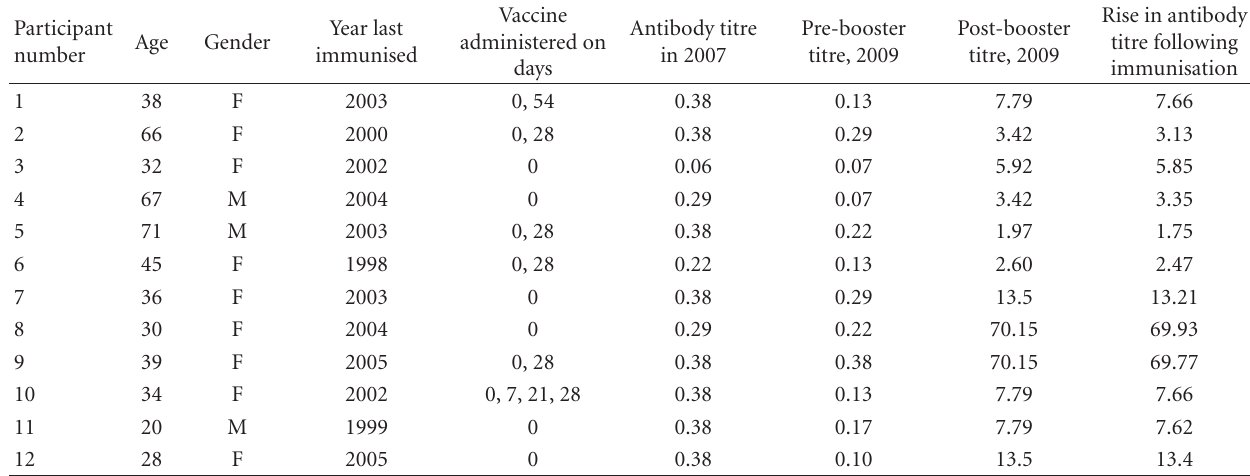
Table 1: Summary of the results obtained for each participant.